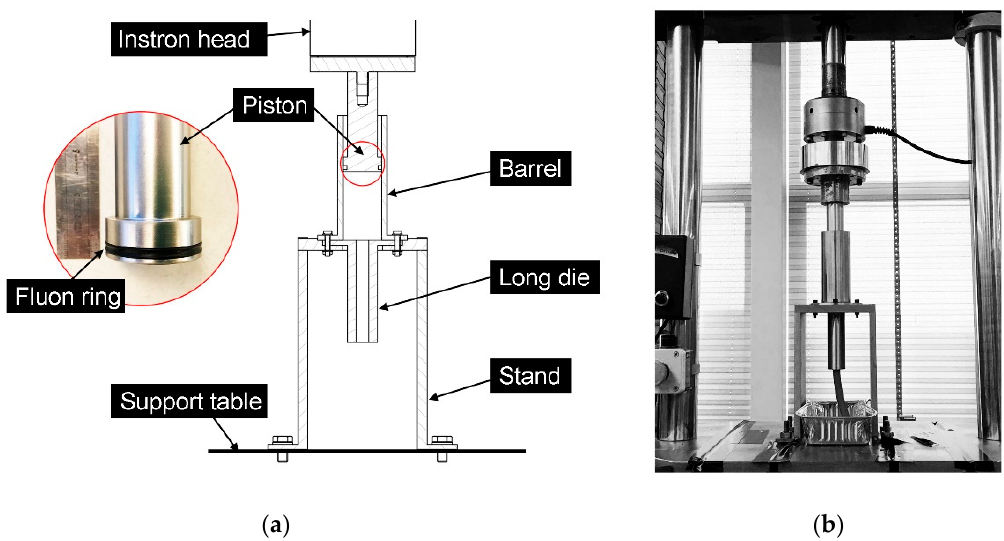
Figure 2. ( a ) Section drawing of the ram extruder; ( b ) Photograph of the ram extruder.